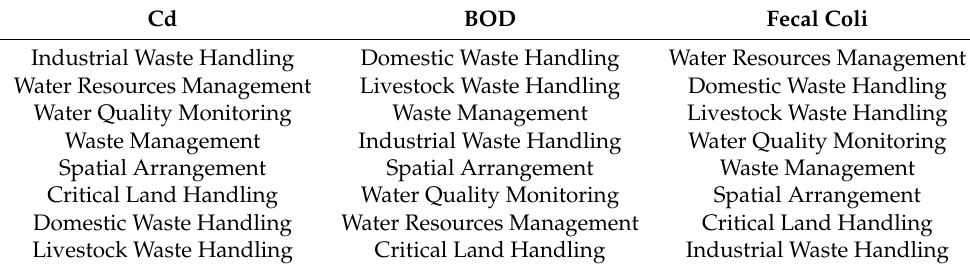
Figure 6. Simulations of the relationship between the pollution programs to each key parameter: ( a ). Cadmium with Industrial Waste Treatment Program; ( b ). Biochemical Oxygen Demand with Domestic Waste Treatment Program; ( c ). Fecal Coli with Water Resource Improvement Program. Table 5. Programs that most affect the parameters.